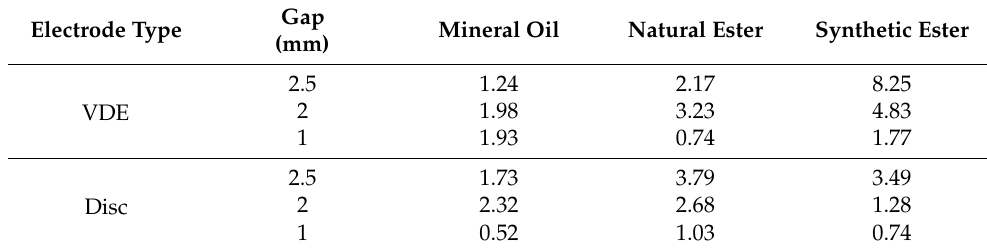
Table 3. Standard deviations for AC BDV test results.